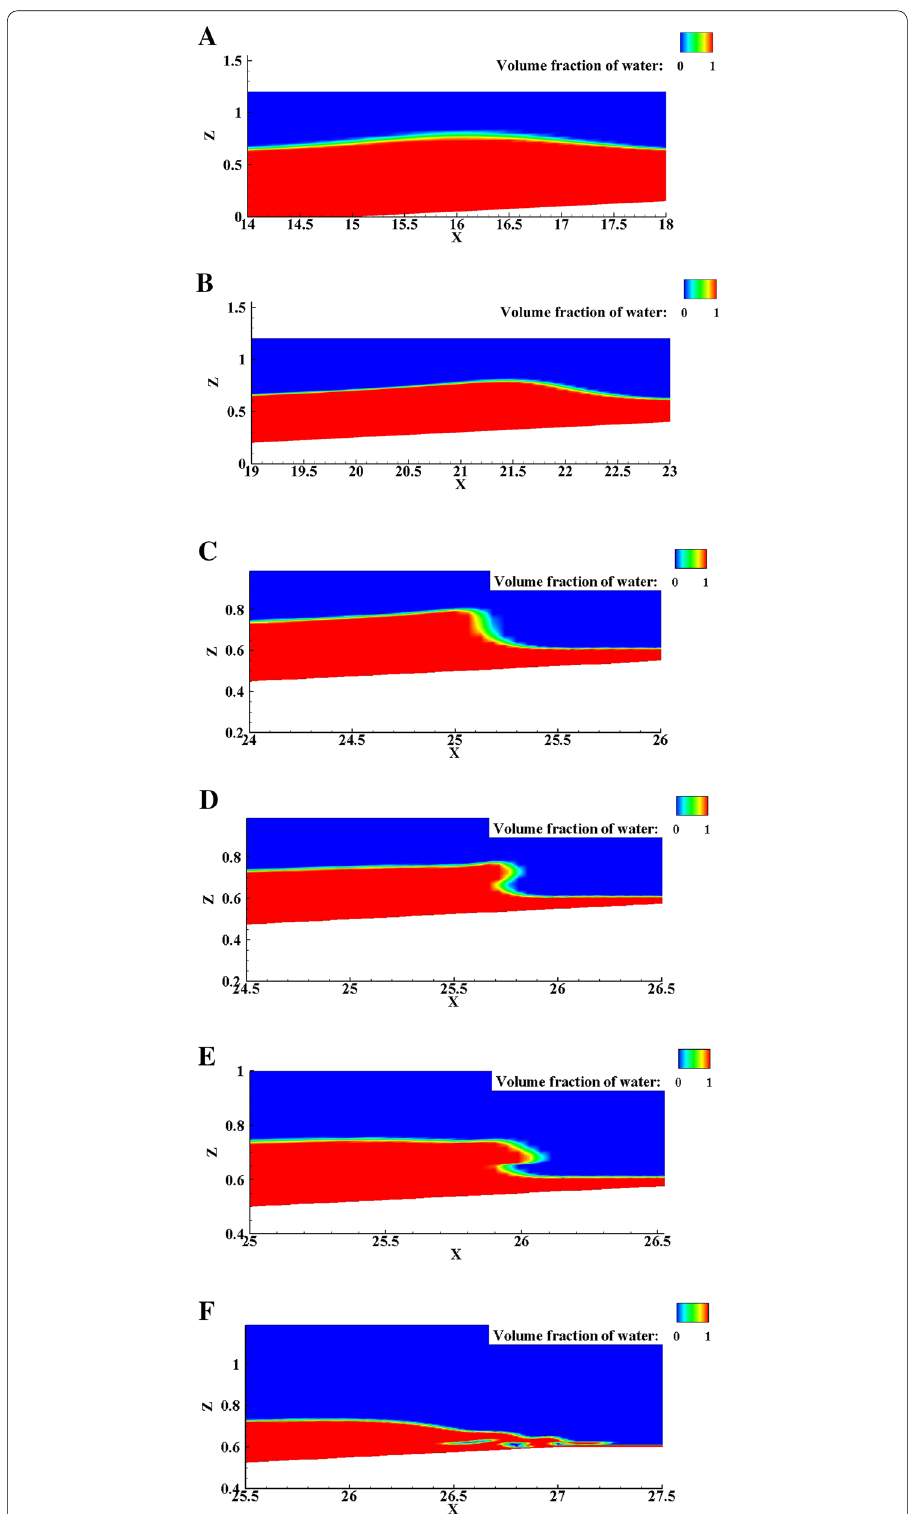
Fig. 5 Phase contours when the solitary wave propagates on the 1/20 slope in the case with h 0.12 m: a t 8.00 s, b t 10.00 s, c t 11.50 s, d t 11.71 s, e t 11.86 s, f t 12.20 s (units of axes: = = = = = =